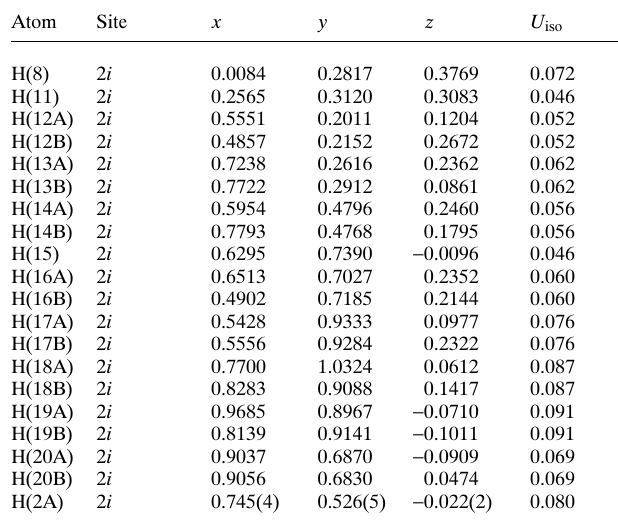
Table 1. Data collection and